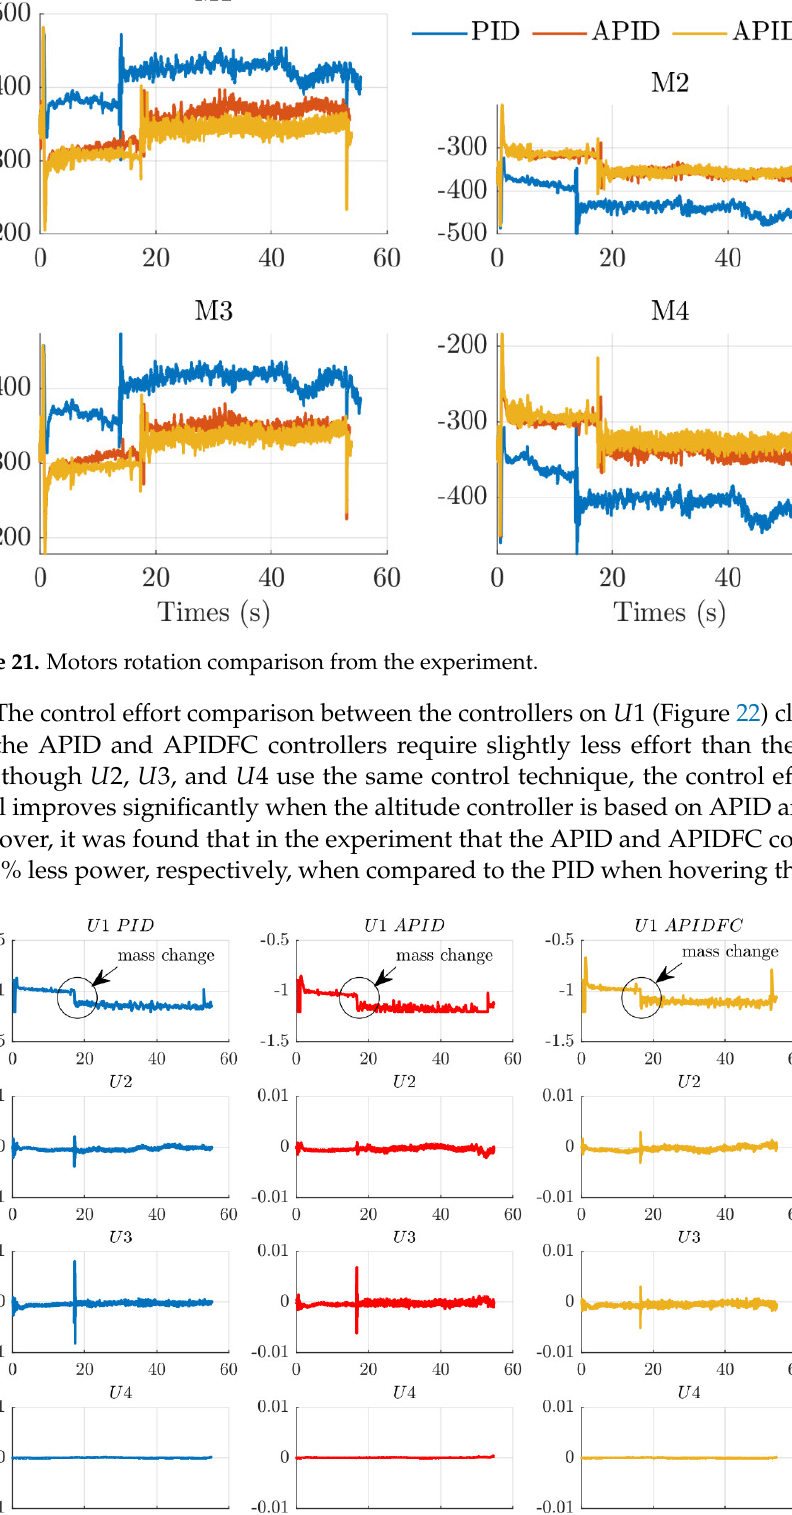
Figure 22. Control effort comparison between controllers.